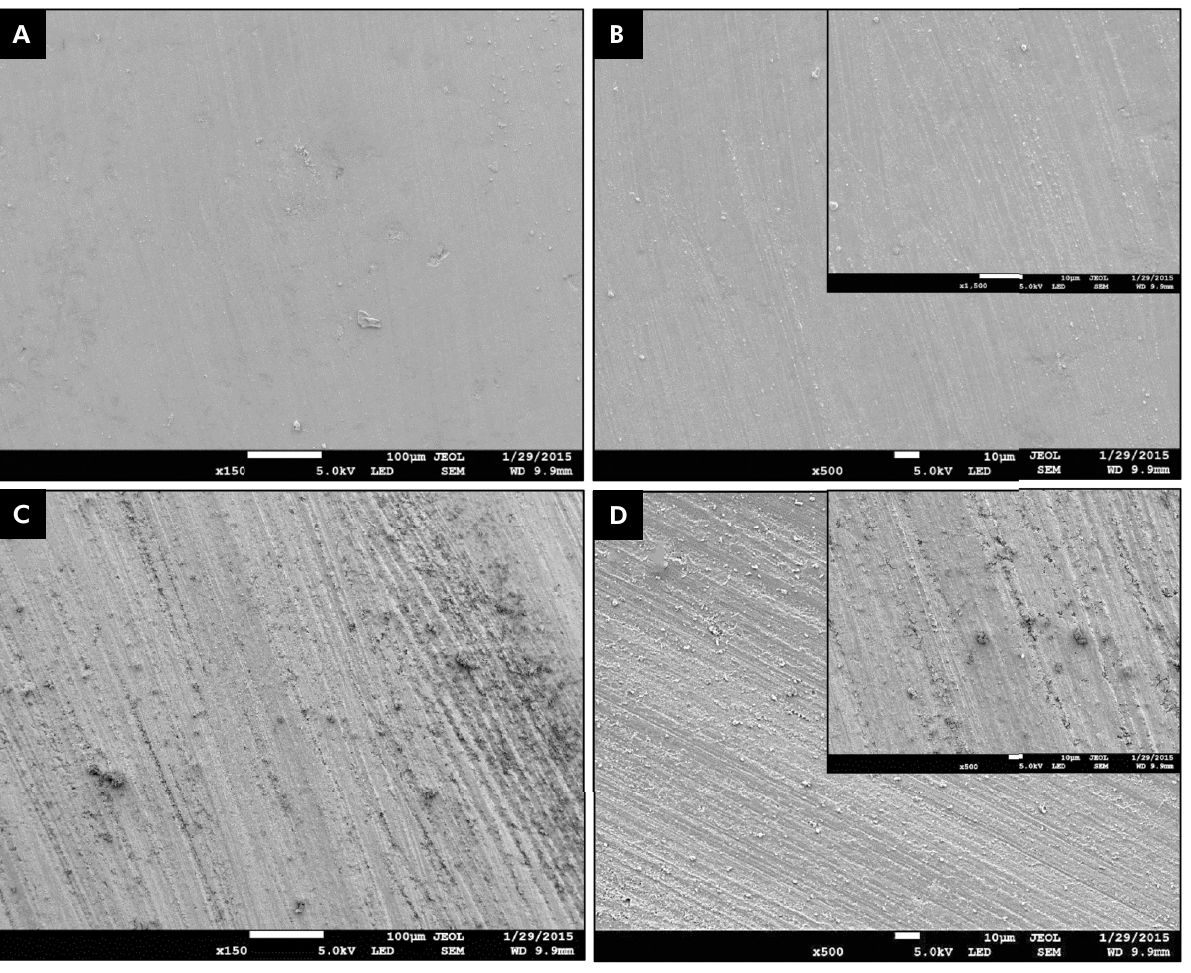
Figure 2. SEM images showing the surface topography (images “a” and “b”) and cross-sectional surface (images “c” and “d”) of a composite resin specimen without storage in red wine. Images “a” and “c” represent 150× magnification, and images “b” and “d” 500× magnification; inchart images in “b” and “d” represent 1.500 ×